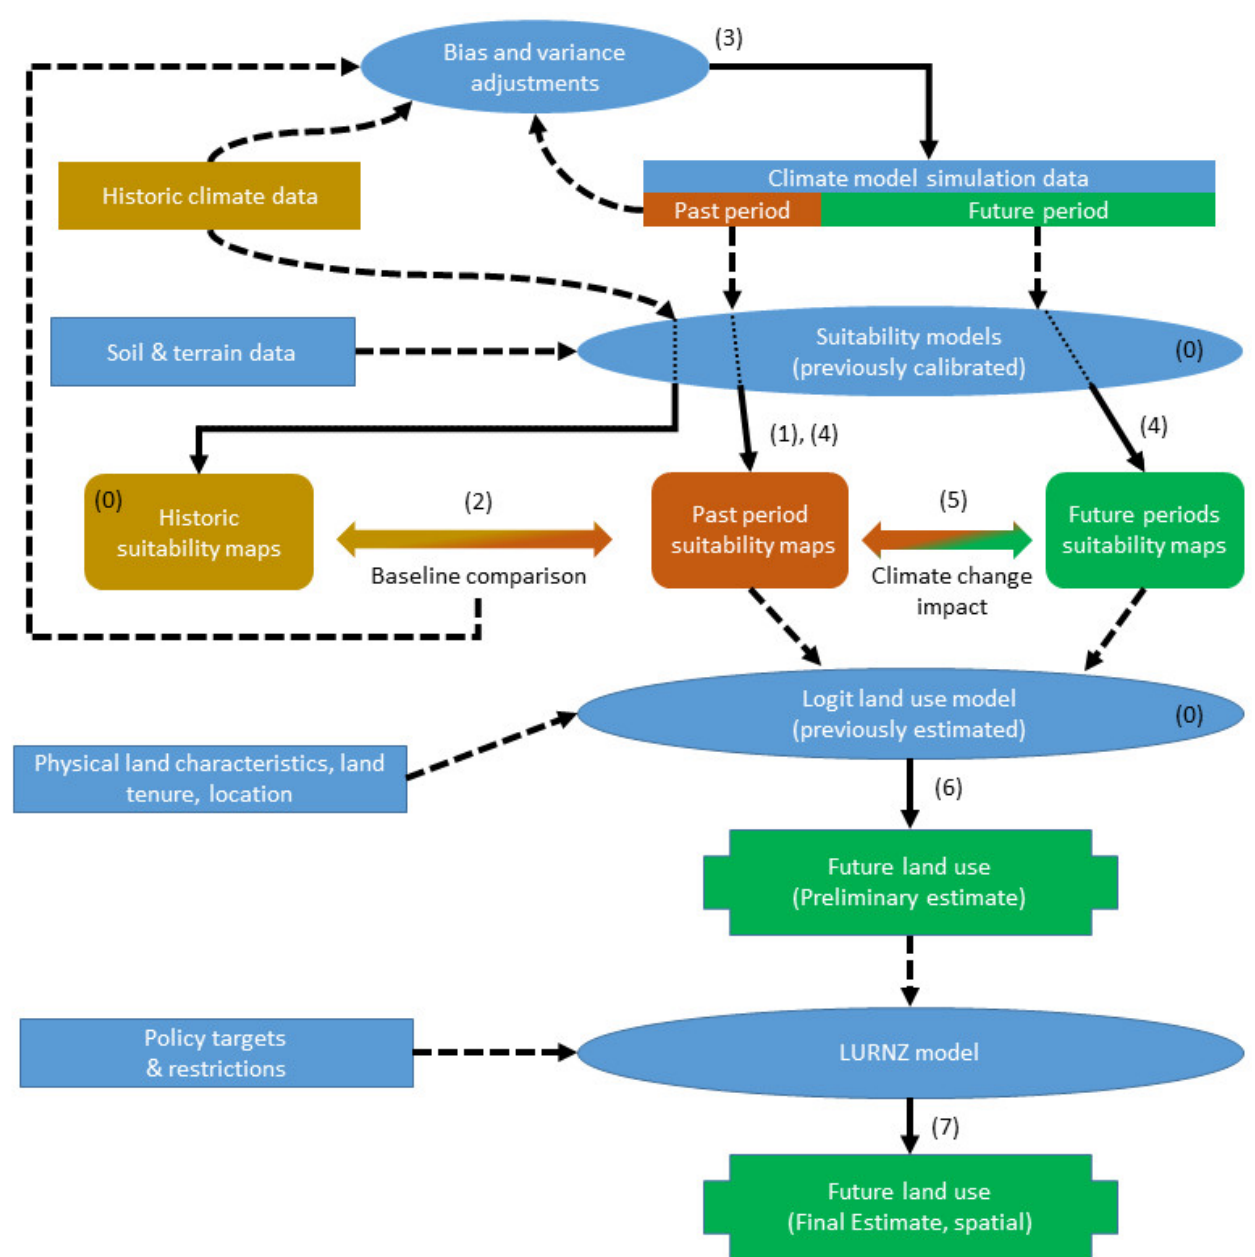
Figure 1. Schema showing framework in this paper. Rectangles with angular corners represent data used; rectangles with rounded edges represent suitability maps; notched rectangles represent land-use projections; ovals represent models and procedures; dashed lines indicate data inputs; solid lines represent outputs of procedures; and the sequences of stages are numbered. Calibrated suitability models, historic suitability maps and a logit land use model estimated from orchard data were provided (Step 0) using outputs from Vetharaniam et al. [23]. Past-period suitability maps were calculated from climate model simulations (Step 1) and compared with the historic suitability map (Step 2), with resulting bias and variance corrections to reduce biases between historic and climate-model past-period maps (Step 3). Future and new-past period maps are calculated from corrected climate data (Step 4) and climate change impacts on suitability are projected (Step 5). Maps in Step 4 provide inputs to the logit model to obtain preliminary land use estimates (Step 6). These inputs are refined by the Land Use in Rural New Zealand (LURNZ) model [24] (Step 7). Data and outputs based on historic observation, and past- and future-period climate-model simulation data are coloured mustard, brown and green, respectively.